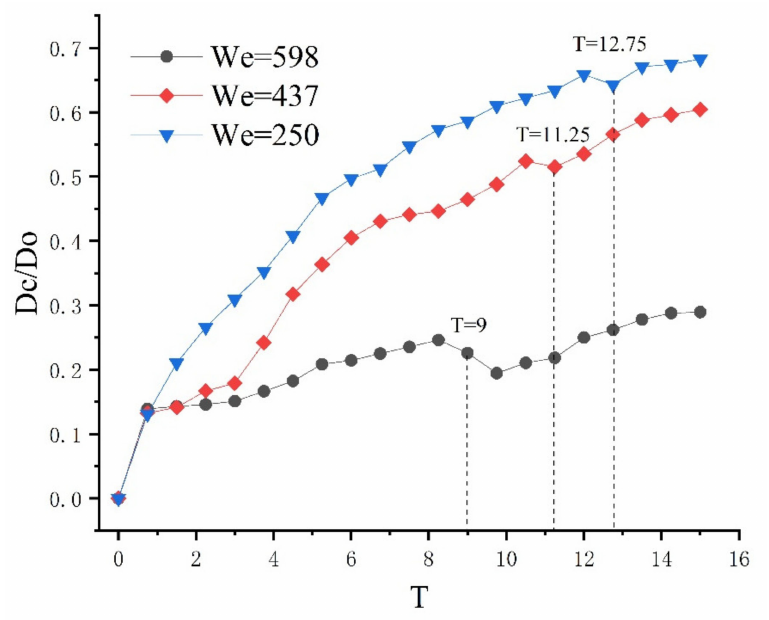
Figure 8. The dimensionless crown rim diameter changing with dimensionless time under three different Weber